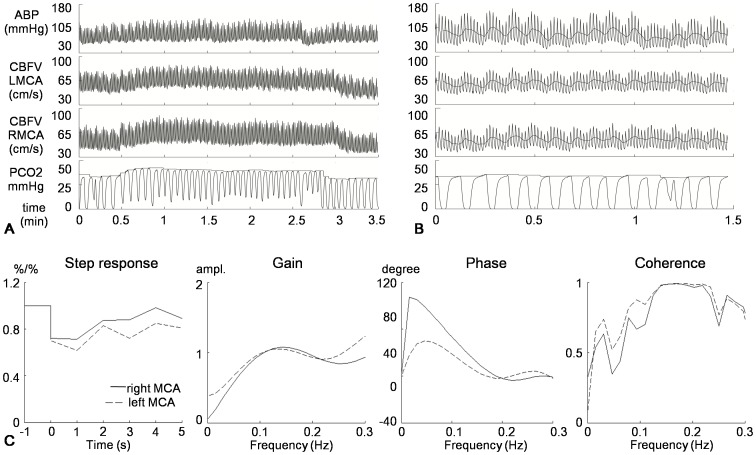
Illustrative recording of cerebrovascular reactivity testing and dynamic cerebral autoregulation analysis.A 52-yr-old patient with severe stenosis of the left MCA and mild stenosis of the right MCA. (A) A rebreathing test for cerebrovascular reactivity. Values were 1.30%/mmHg on the left and 2.21%/mmHg on the right side. (B) Raw data of spontaneously breathing, showing the oscillations of the blood pressure and cerebral blood flow velocity. (C) Transfer function analysis shows, compared with the right side, the recovery of the blood flow of the left side was slower, the phase shift was lower, and the coherence was higher.